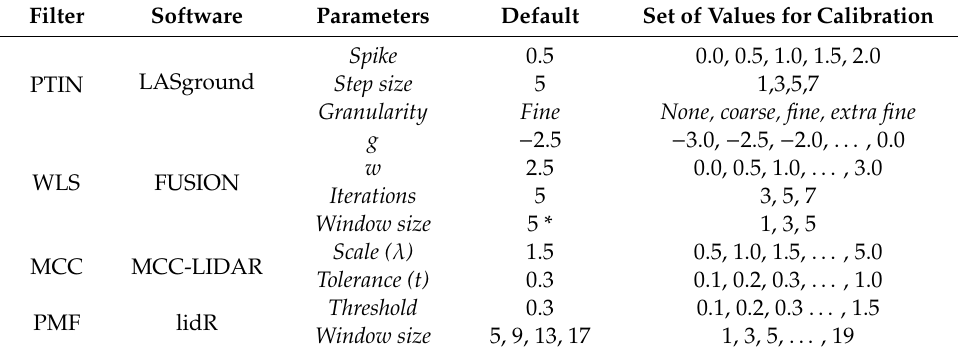
Table 2. The default filtering parameter values and the corresponding set of values for calibration of the progressive triangulated irregular network (PTIN), weighted linear least-squares interpolation (WLS), multiscale curvature classification (MCC), and progressive morphological filter (PMF). The particularities of the parameters are defined in Sections 2.4.1–2.4.4. Filter Software Parameters Set of Values for